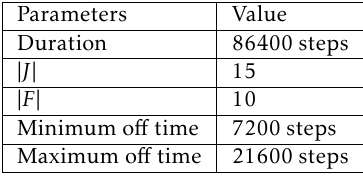
Table 2. The test setting used to create three synthetic